Question: Which visualization type does this figure use?
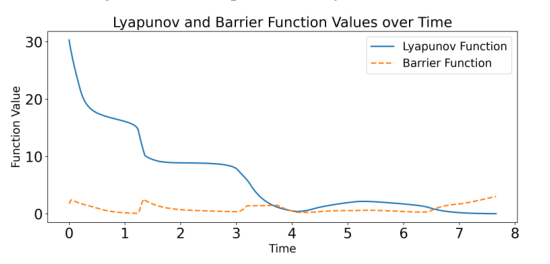
Answer: line